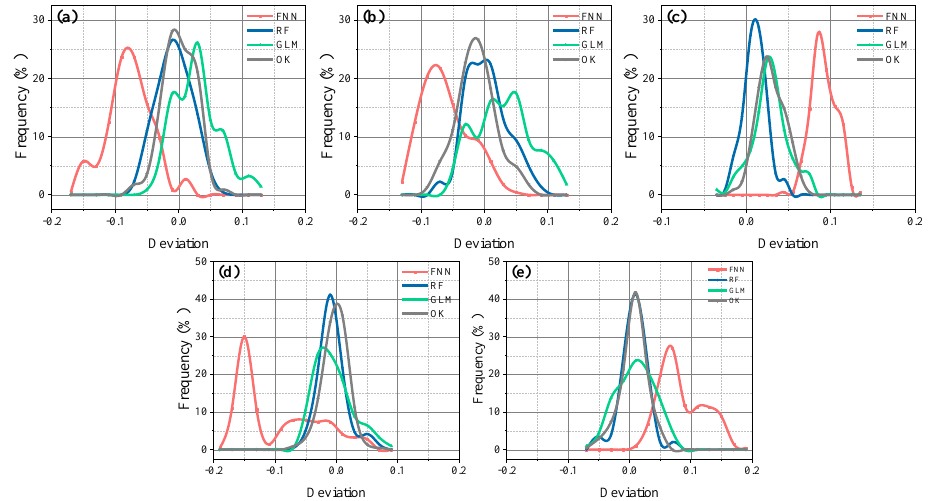
Figure 6. Statistical histogram of the difference between original CCI SM and other four kinds simulated SM Deviation calculated by simulated data and ESA CCI data. Region 1–5 was symbolized by ( a – e ) in sequence.